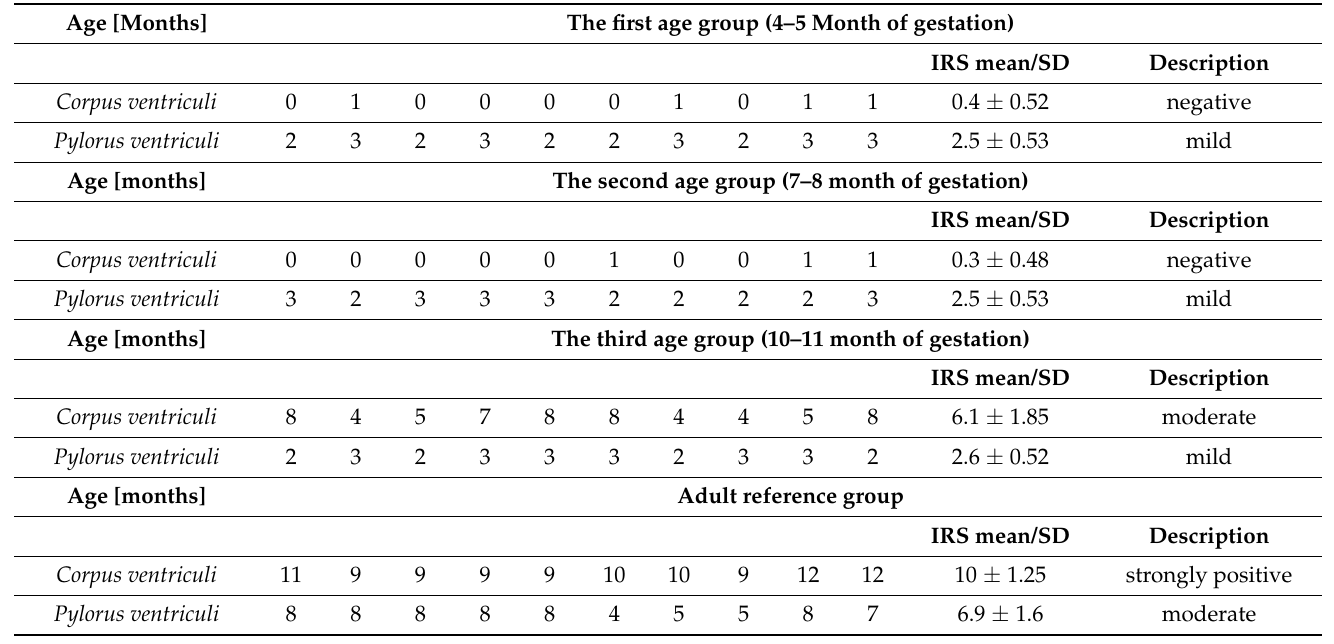
Figure 8. Immunoreactivity of anti-secretin receptor antibody in the pyloric mucosa, 40×. ( A ) the first age group, ( B ) the second age group, ( C ) the third age group, ( D ) adult reference group. The arrow indicates positive immunohistochemical reaction. Table 5. Immunoreactivity of anti-secretin receptor